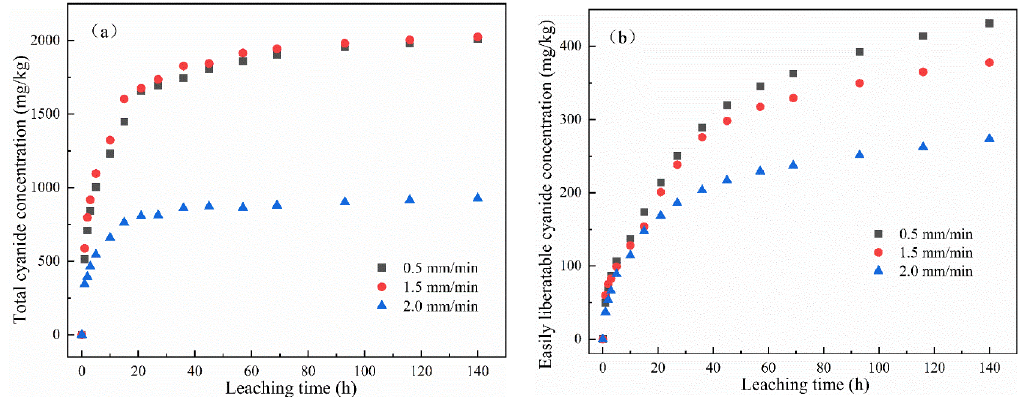
Figure 4. Effect of leaching intensity on cumulative release of ( a ) total cyanide and ( b ) easily liberat- able cyanide at different